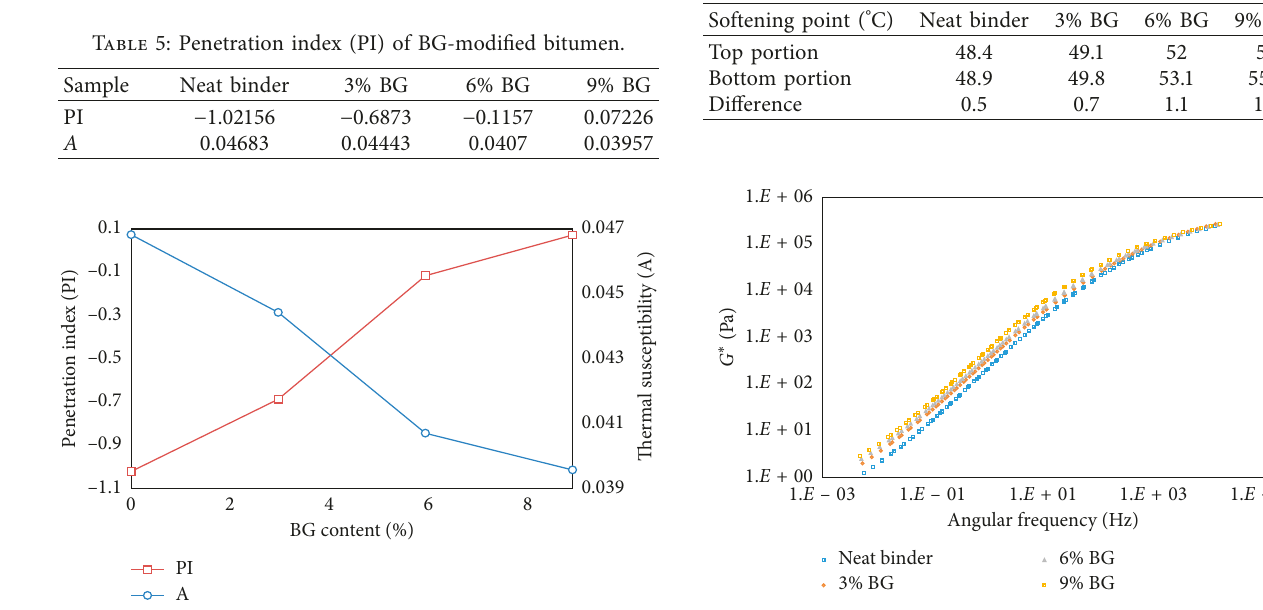
Figure 5: Effect of BG addition on penetration index and thermal susceptibility.